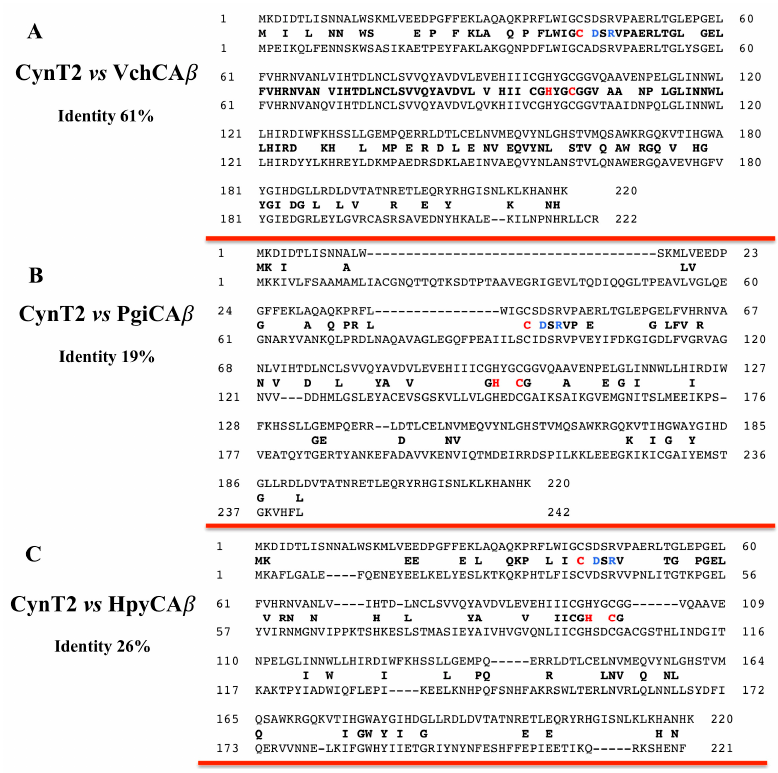
Figure 2. Pairwise comparison of the CynT2 polypeptide chain with VchCA β ( A ), PigCA β ( B ), and HpyCA β ( C ) amino acid sequences, respectively. The identical amino acid residues are indicated between the two aligned amino acid sequences (black bold). The amino acid residues participating in the coordination of the metal ion are indicated in red (Cys, His, and Cys), whereas the catalytic dyad involved in the activation of the water molecule coordinated to zinc (Asp–Arg) is shown in blue. The pairwise alignment was performed with the program Blast Global Align. The accession numbers of the aligned sequences are: EEW0221051.1, CynT2 from Escherichia coli ; WP_002051193.1, VchCA β from Vibrio cholerae ; WP_012458351.1, PgiCA β from Porphyromonas gingivalis ; WP_000642991.1, HpyCA β from Helicobacter pylori .